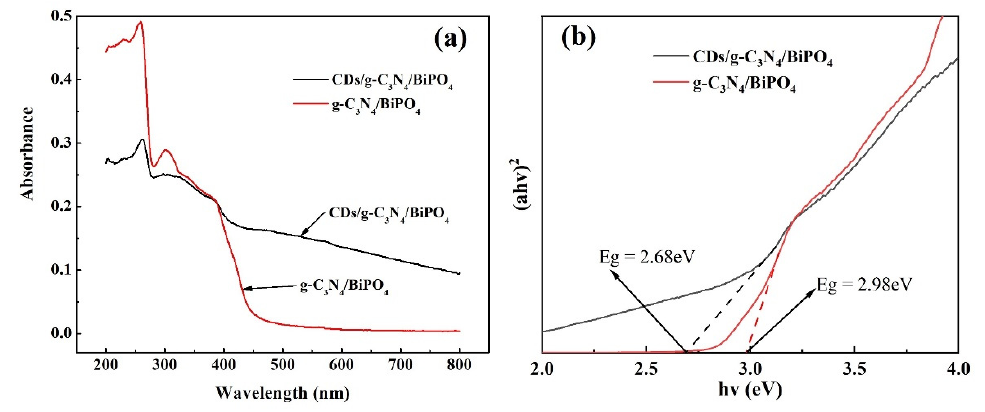
Figure 5. ( a ) UV–Vis absorption spectra, ( b ) Tauc plots curve of CDBPC.